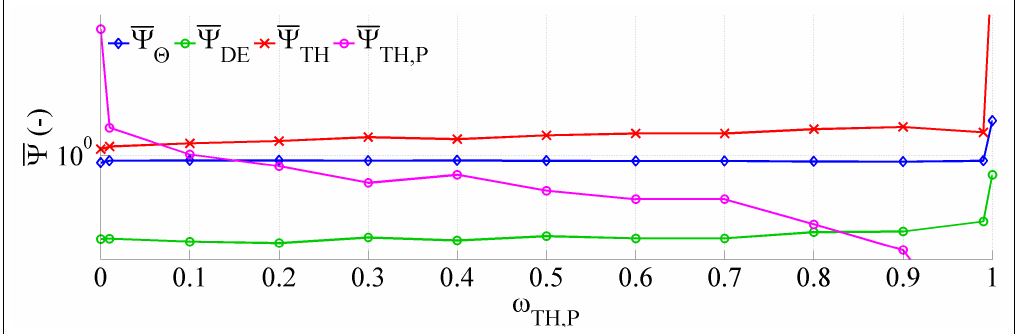
Figure 15. The criteria function member values as the function of ω TH , P